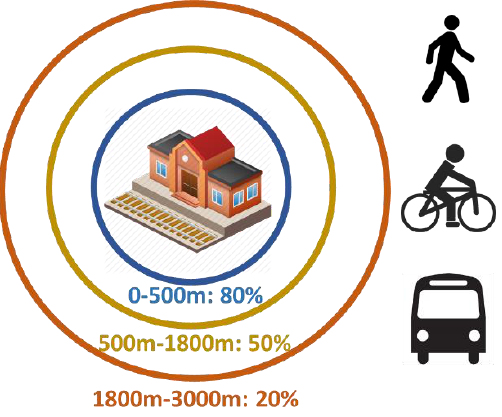
Figure 6 Station catchment buffer areas for intercity stations